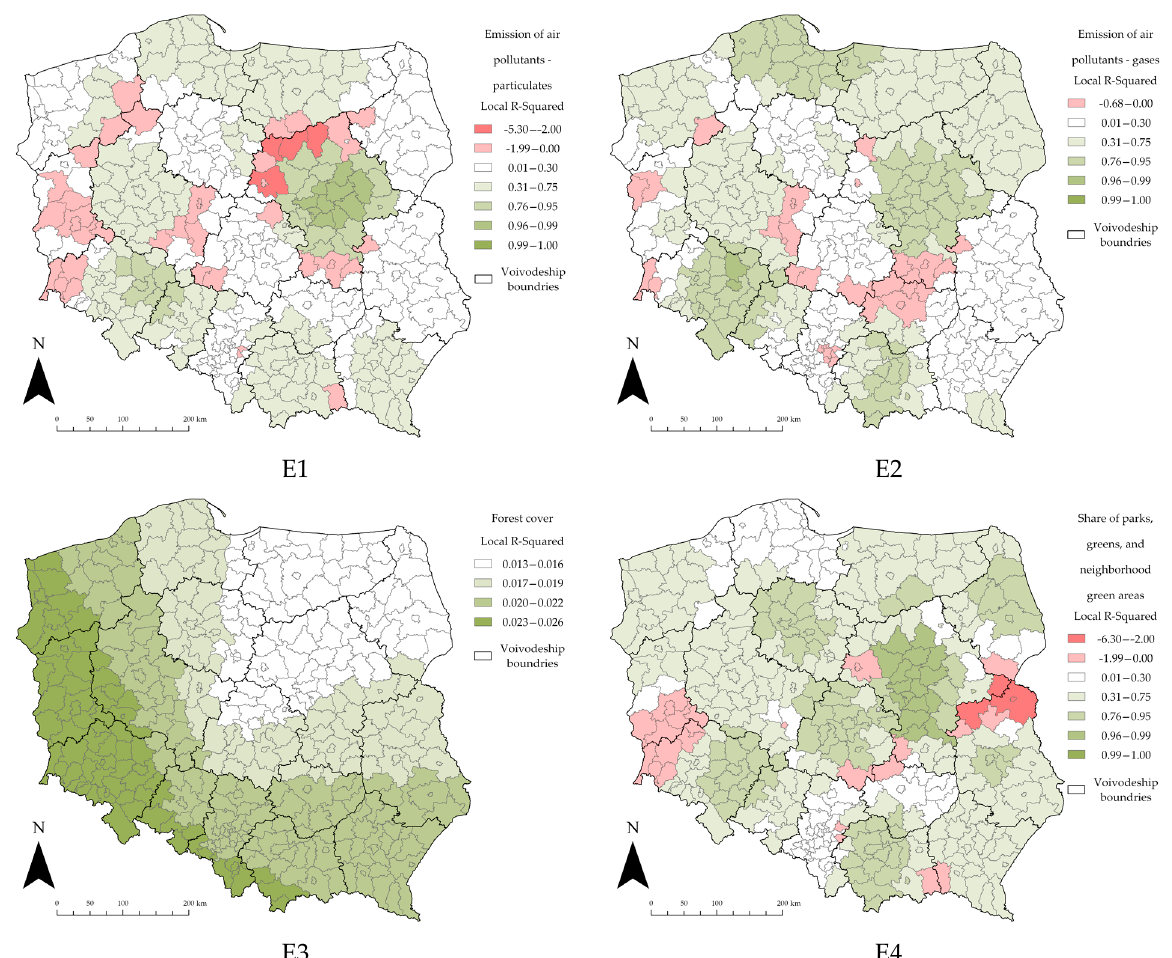
Figure 7. Local R 2 estimates for the “Environmental” section. Source: own elaboration using ArcGIS Pro 2.9 by Esri.